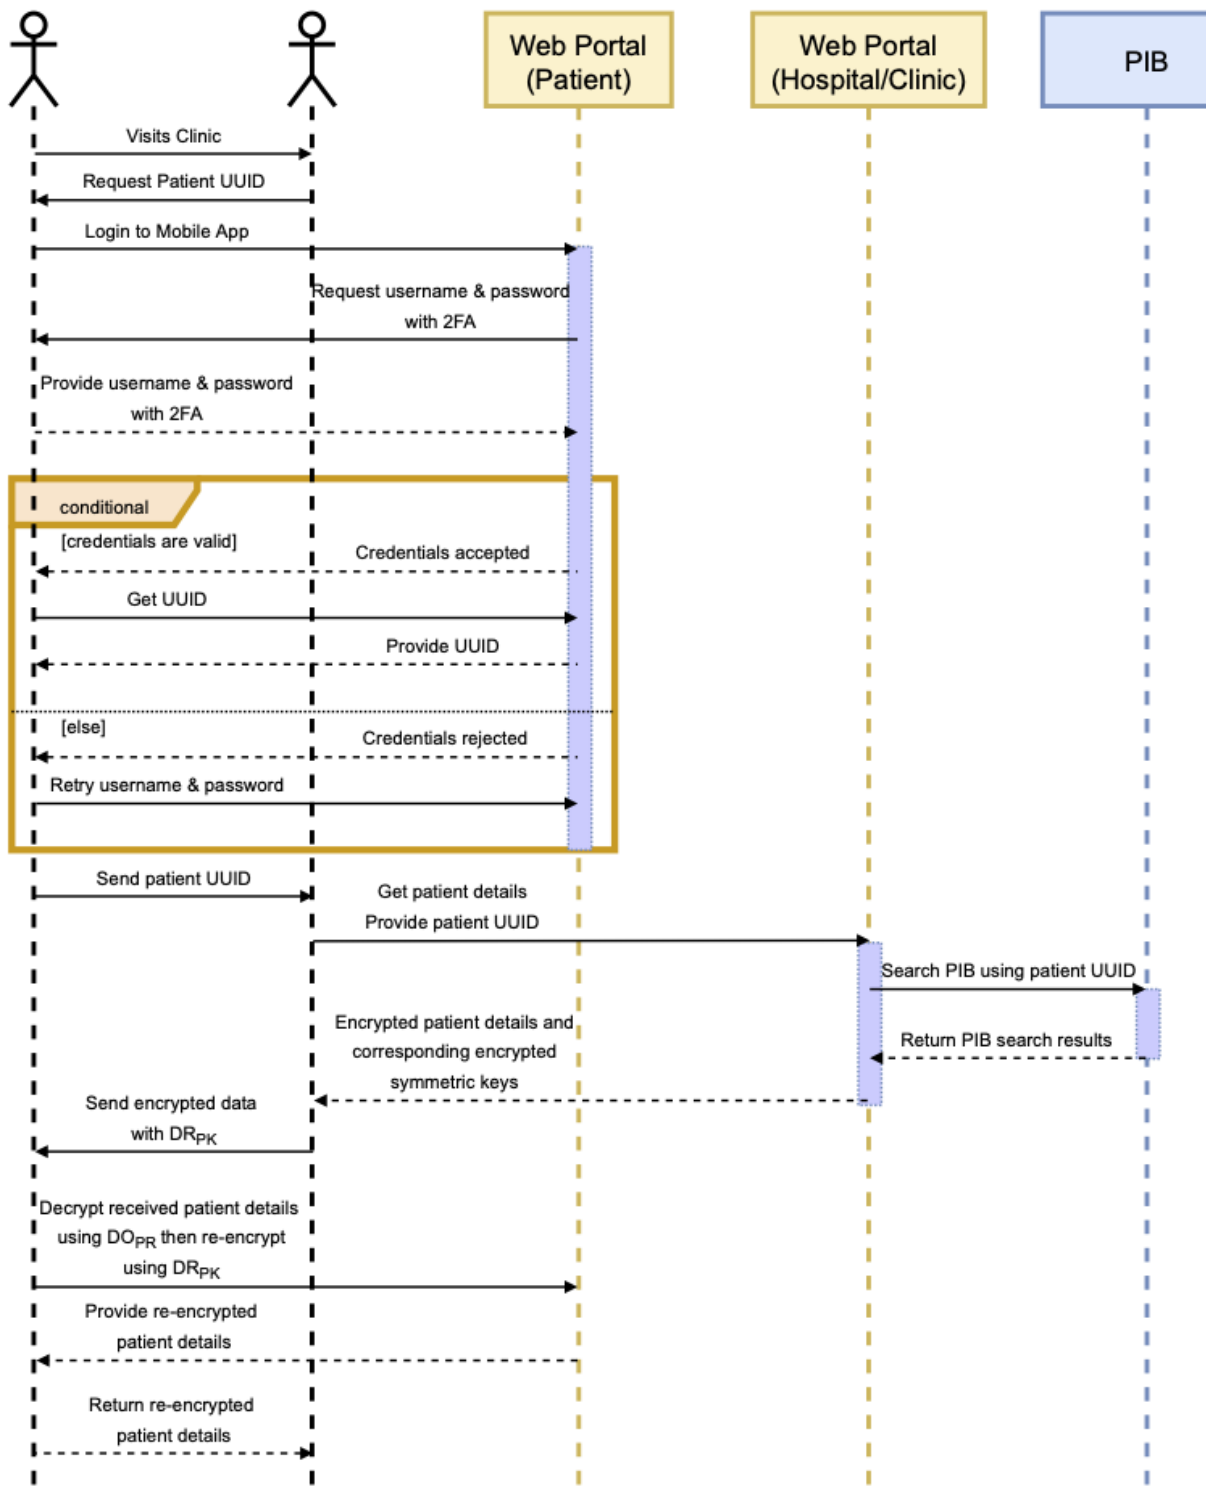
Figure 13. Patient verification sequence diagram.